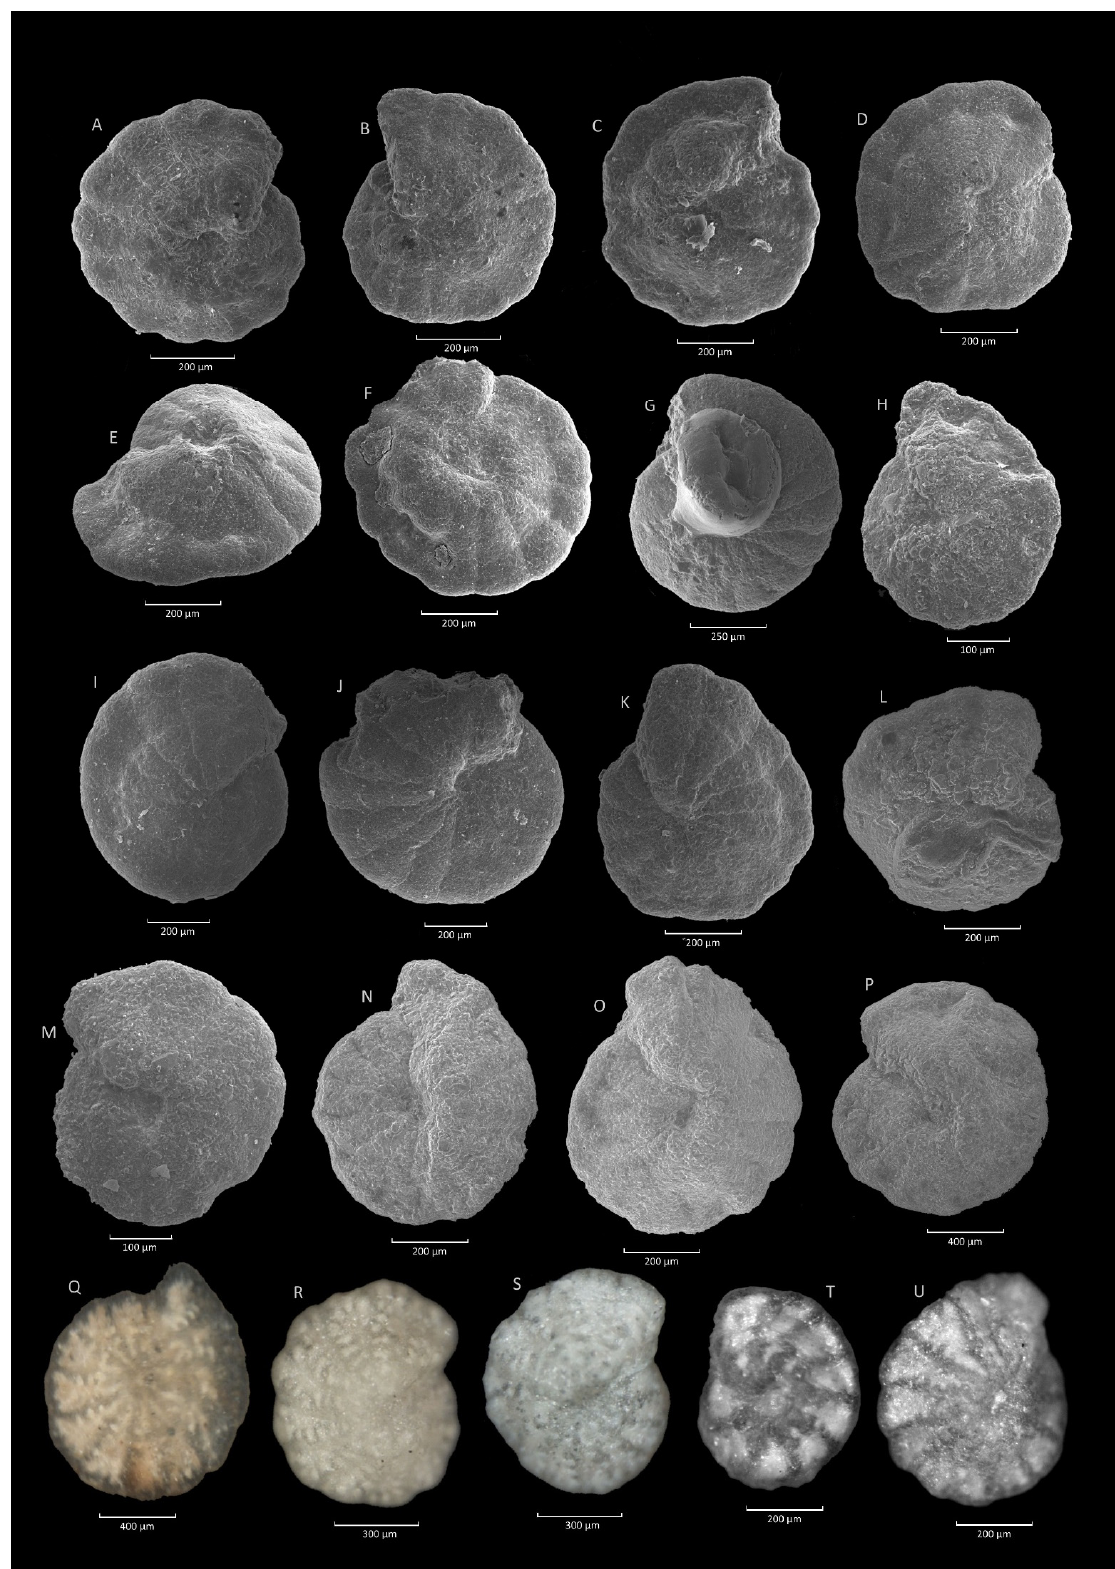
Figure 15. Reticulophragmium amplectens (Grzybowski). ( A – C ): Krzesławice section; ( D – F ): Leszczawa section; ( G ): Por˛eby- Czarnot ó wki section; ( H ): Leszczawa section; ( I – K ): Sucha Beskidzka section; ( L , M ): Por˛eby-Czarnot ó wki section; ( N ): Lipie section; ( O , P ): Por˛eby-Czarnot ó wki section; ( Q , R ): Gorlice section; ( S ): Zamczysko section; ( T , U ): Jezioro Ro˙znowskie